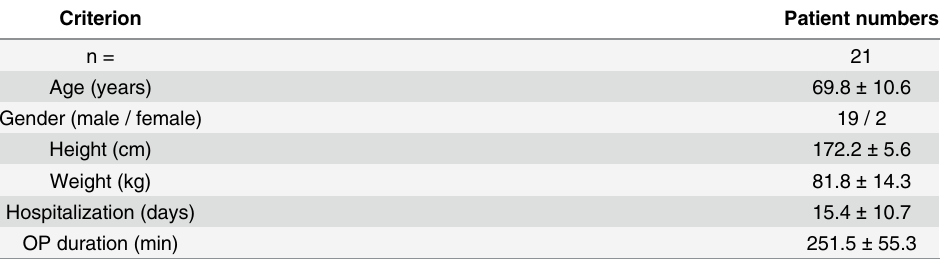
Table 1. Characteristics of all recruited patients. Shown are means of the criteria ±